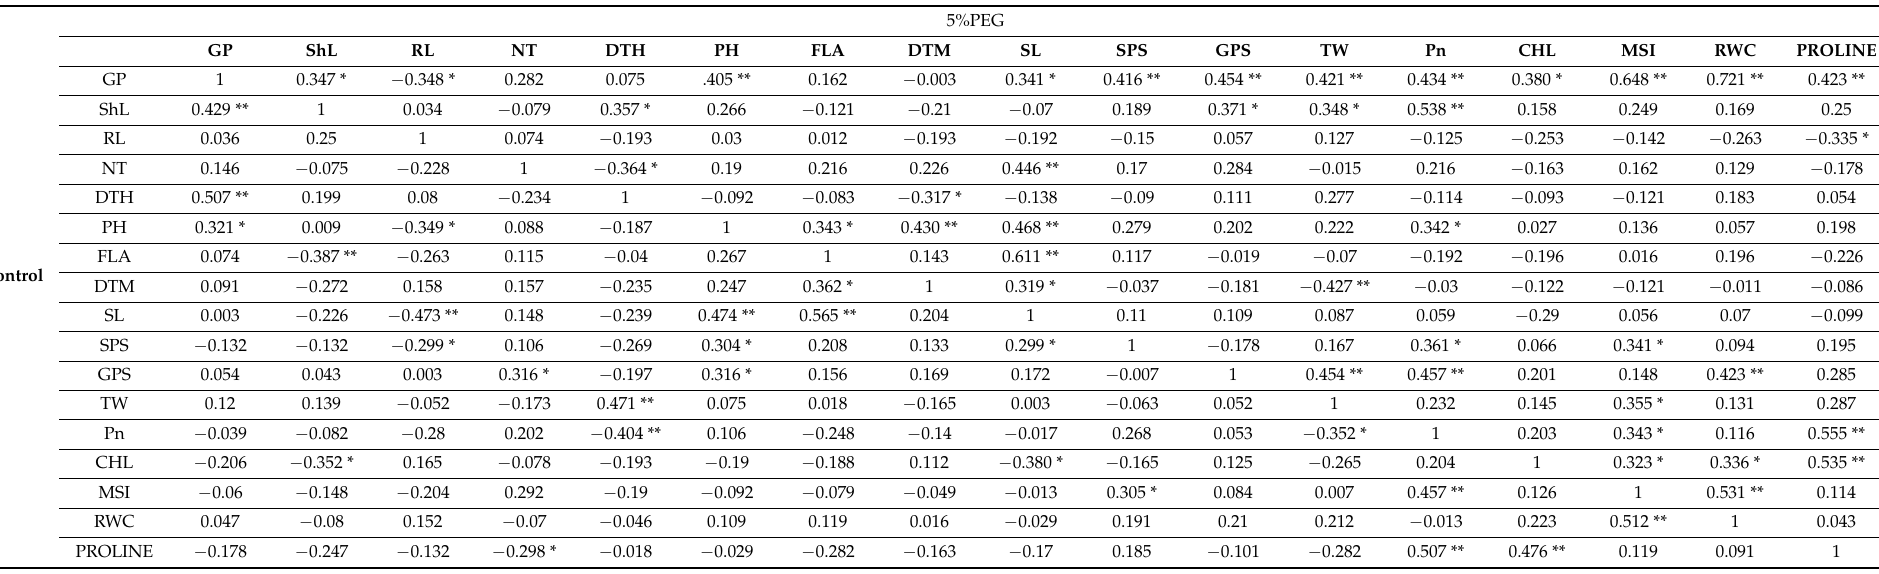
Table 5. Pearson’s correlation coefficients (r) describing the association of morphological, physiological and biochemical traits of 15 wheat genotypes evaluated under drought control (lower diagonal) and 5% PEG (upper diagonal)